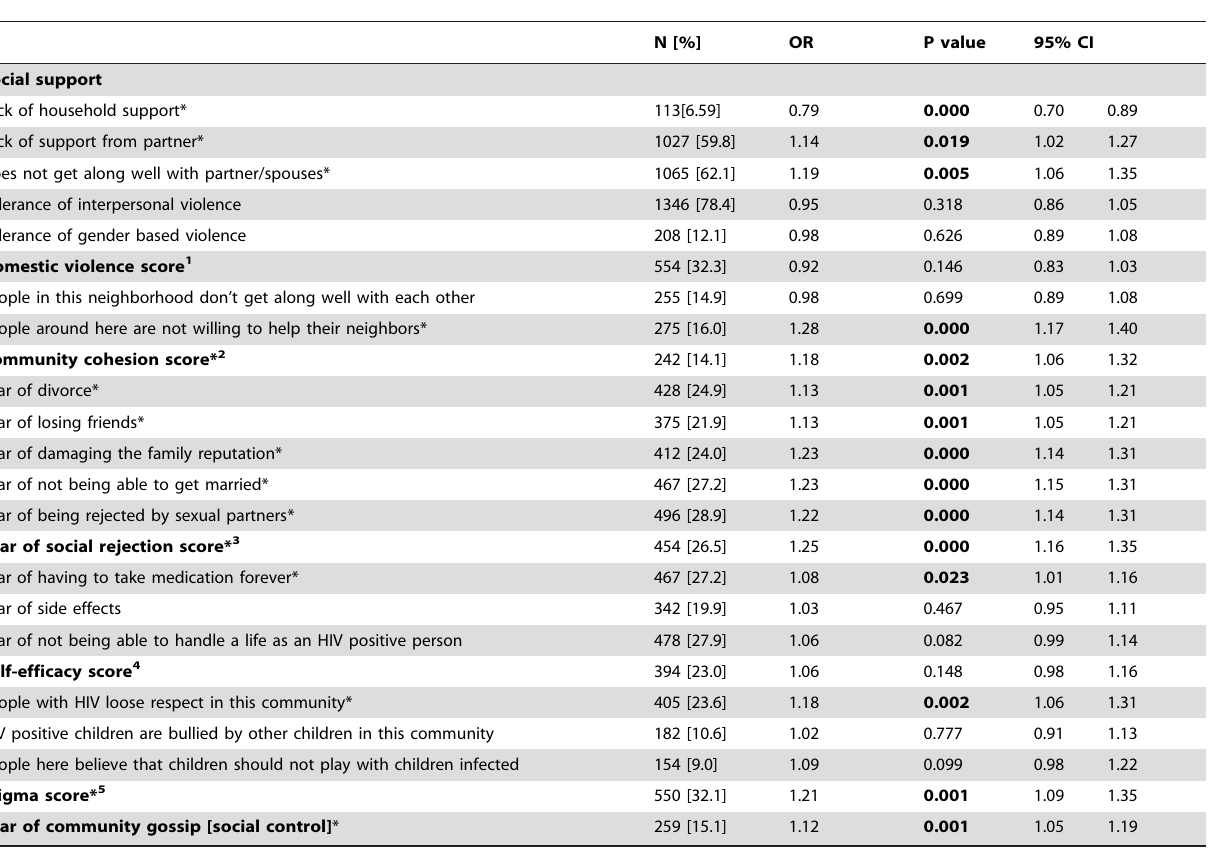
Table 6. Crude odds ratios of social support